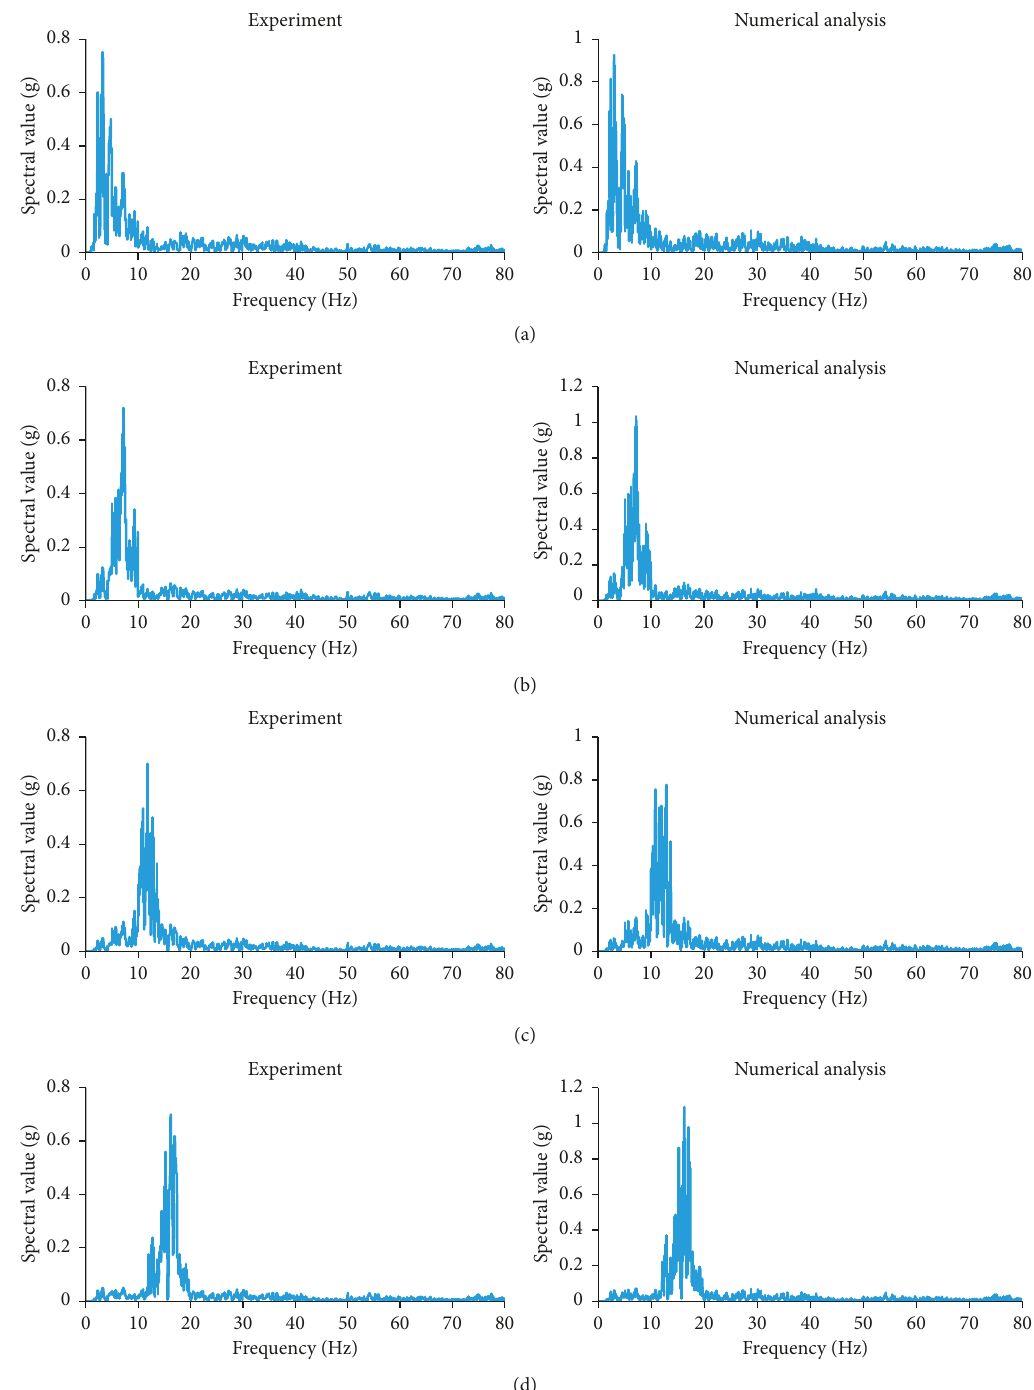
Figure 9: Fourier acceleration amplitude spectrum at point A7 under the Castaic wave (0.4g). (a) Natural slope without vegetation. (b) Hinged block slope. (c) Hinged block ecological slope. (d) Anchor + hinged block ecological (1) In the initial loading process, the loading curve is in a linear skeleton, such as 0-1 curve segment shown in Figure 10. (2) If the loading curve or unloading curve intersects with the skeleton curve before the exchange of loading and unloading stages, such as the 1–3 ′ curve